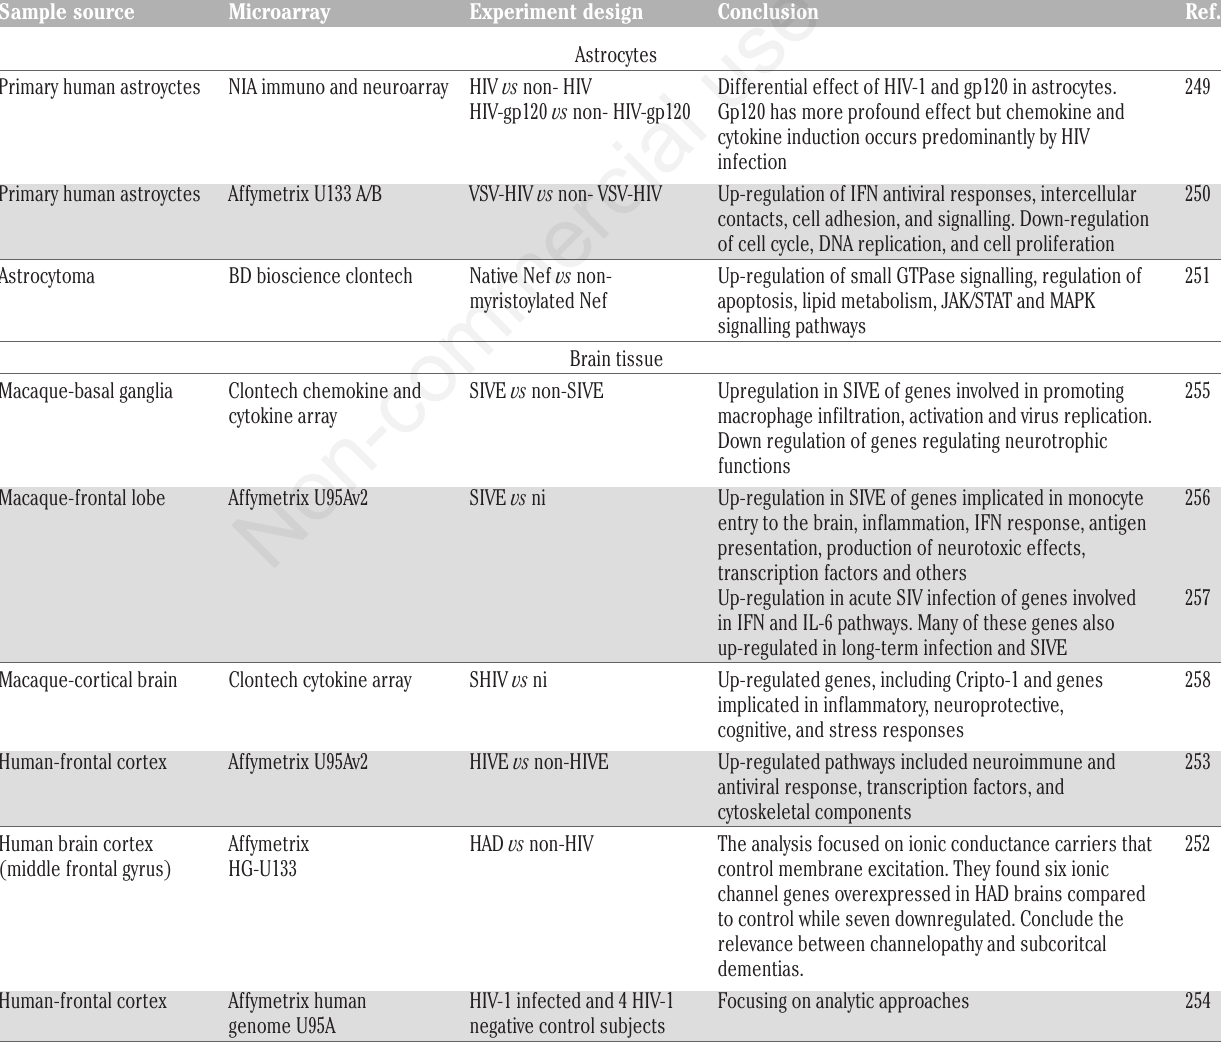
Table 2. Gene profiling studies in HIV-1 infected astrocytes and HIV-1 or SIV infected brains. Sample